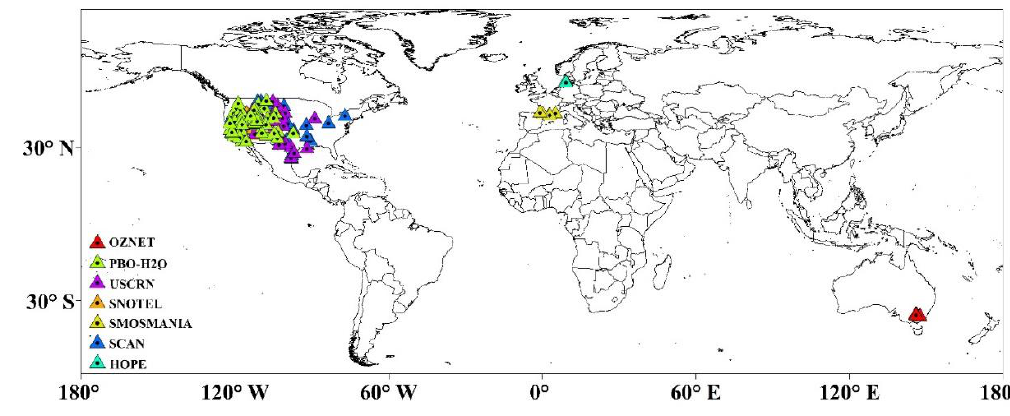
Figure 1. The locations of the ISMN validation stations used in this study at the global scale.